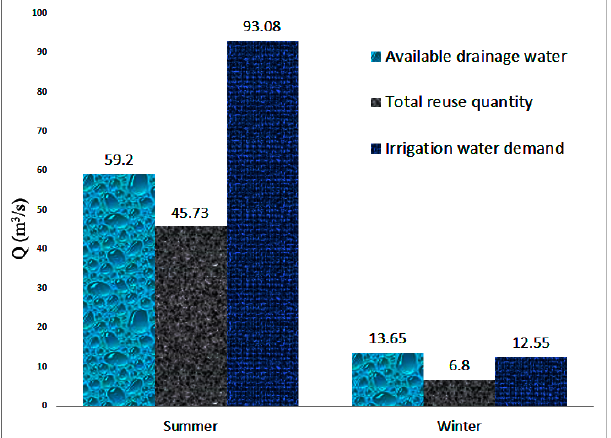
Figure 6. Water demand, availability and reuse in the Osan stream drain.